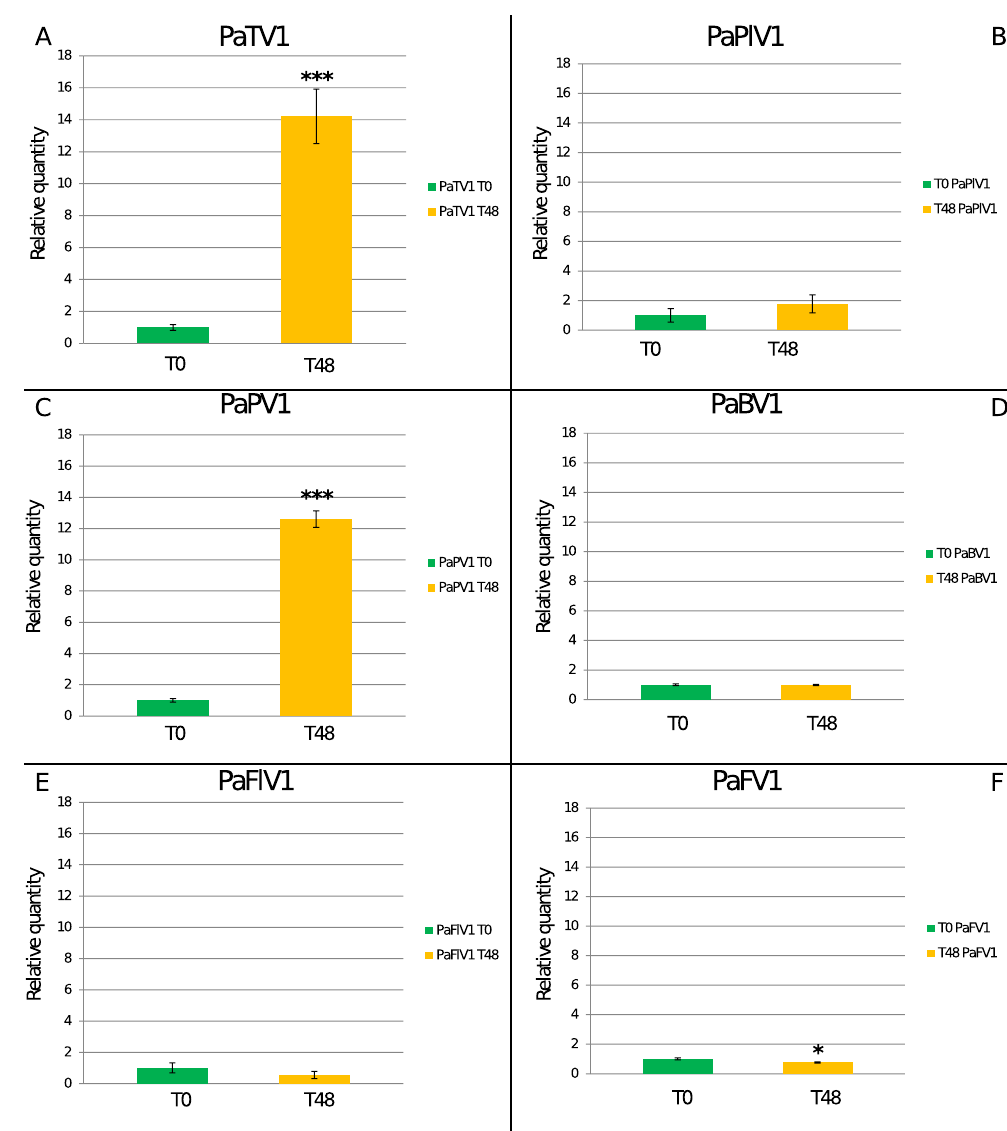
Figure 3. Absolute quantification of viral RNA in Nicotiana tabacum BY2 protoplasts at T0 and T48 time points. Quantitative Reverse transcriptase PCR (qRT-PCR) data were used. We present the data as a fold change of viral RNA at T48 compared to T0 to which we arbitrarily assigned the value 1. In panel A: absolute quantification of the Totivirus Penicillium aurantiogriseum totivirus 1 (PaTV1) quantification show ca. 14 times more RNA at T48 (yellow bar) than at T0 (green bar). In panels C: quantification of the Partitivirus Penicillium aurantiogriseum partitivirus 1 (PaPV1) show ca. 12 times more viral RNA at T48. Panels B,D,E and F show data for the other viruses: none of them displays a statistically significant increase in virus RNA load. * P < 0.05 ** P < 0.01 and *** P <